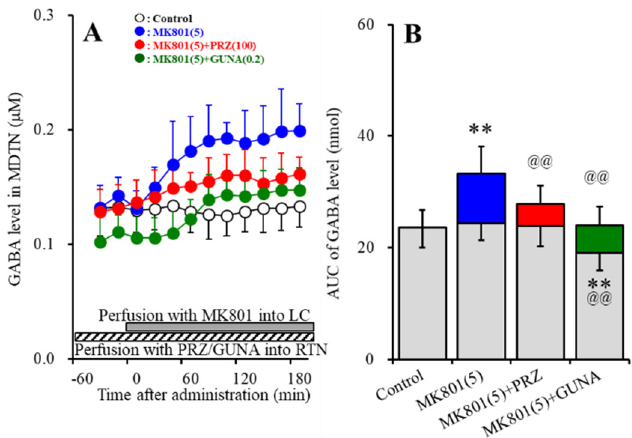
Figure 7. Effects of local administration of PRZ and GUNA into the RTN on MK801-induced GABA release ( A ) in the MDTN. Ordinate: mean ± SD (n = 6) of extracellular GABA level (μM); abscissa: time after MK801 administration (min). Stripped bars indicate perfusion with 100 μM PRZ or 0.2 μM GUNA into the RTN. Gray bars indicate perfusion with 5 μM MK801 into the LC. ( B ) indicates the AUC values of extracellular GABA level (nmol) after perfusion with MK801 (from 20 to 180 min), based on ( A ). Gray columns represent the AUC values before perfusion with MK801 (basal release). ** p < 0.01; relative to control, @@ p < 0.01; relative to MK801 (5 μM) by MANOVA with Tukey’s post hoc test.